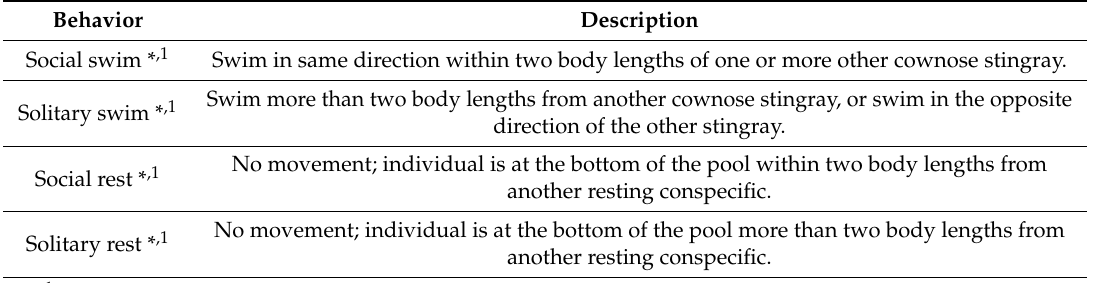
(Table A10) of each cownose stingray was recorded, as well as the number of zoo visitors along the perimeter of the exhibit. Table A10. Cownose ethogram, with behaviors of focus indicated with an asterisk (*). Behavior